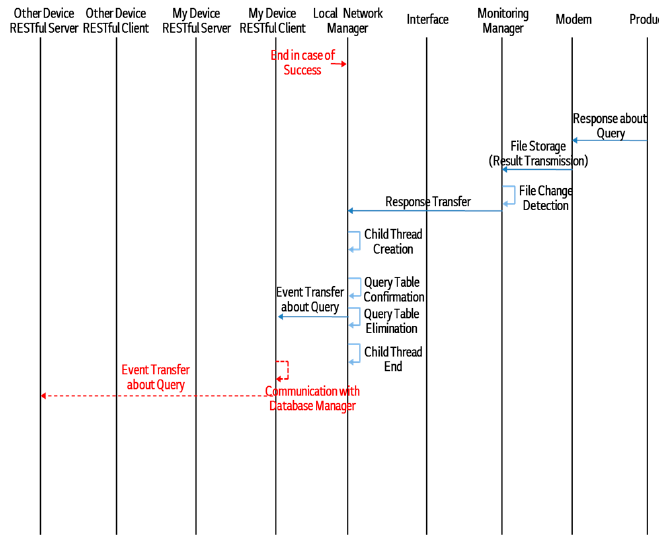
Figure 7. Protocol for receiving and processing queries (part-B).